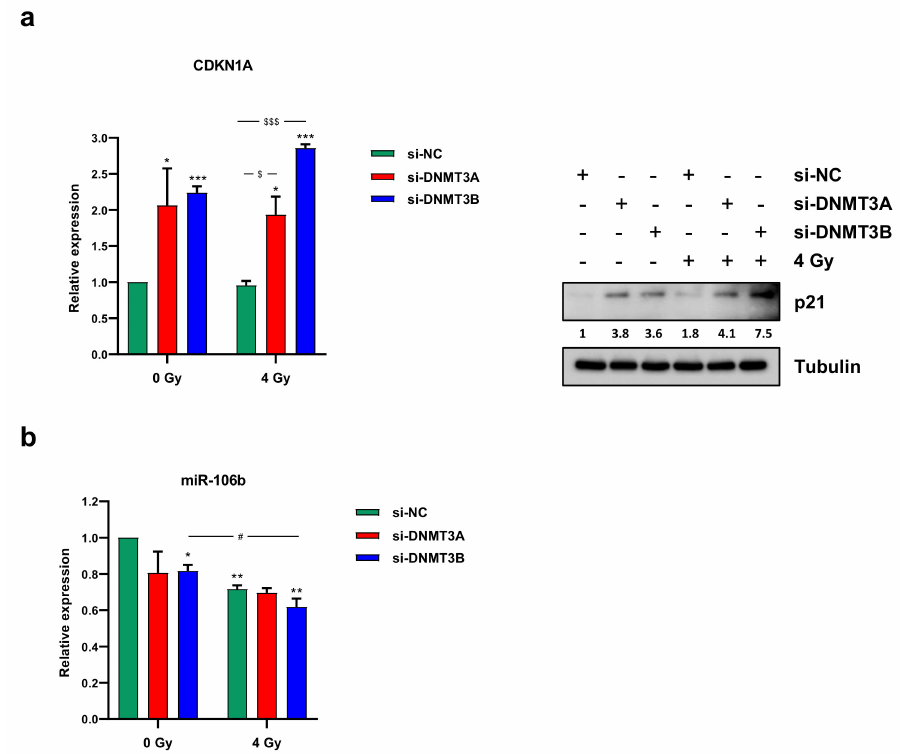
Figure 4. DNMT3A and DNMT3B depletion induced a marked p21 overexpression in irradiated RD cells. ( a ) mRNA (left panel) and protein levels (right panel) of p21 (CDKN1A) in RD cells after DNMT3A or DNMT3B silencing and IR exposure. q-PCR analysis was expressed as fold increase over si-NC/0 Gy, arbitrarily set at 1 and GAPDH was used as endogenous control. Bars represent means ± SD of three independent experiments, each performed in triplicate. Statistical analyses were performed by using two-way ANOVA: ***, p < 0.001; *, p < 0.05 vs. si-NC/0